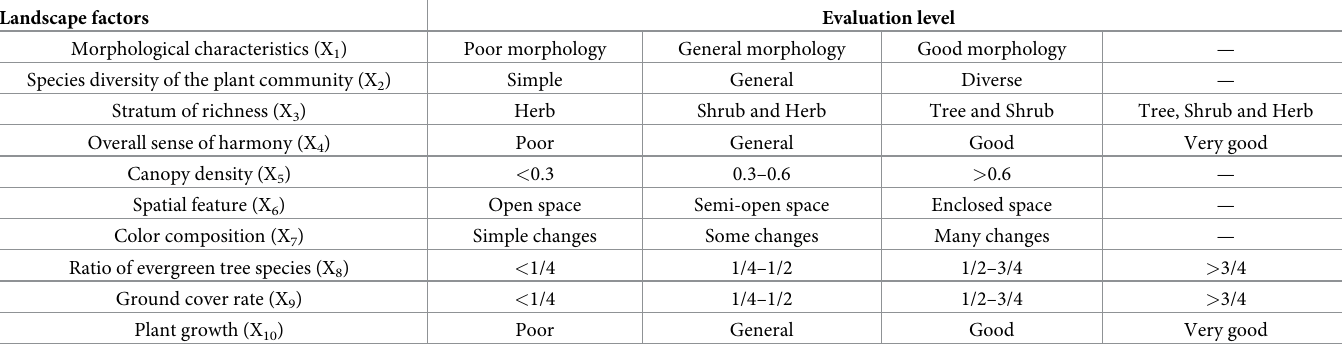
Table 1. Extraction of landscape factors of the winter plant community landscape in Yangzhou,